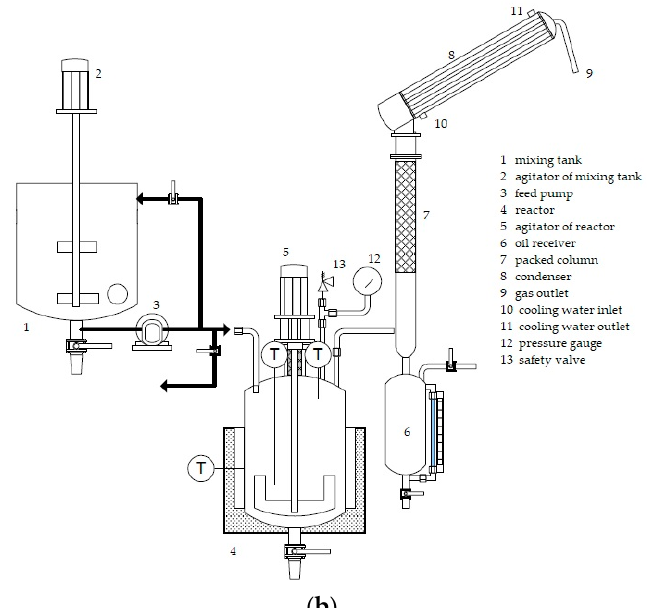
Figure 2. Co-pyrolysis prototype for a 10 kg/day process: ( a ) photograph of the prototype setup; ( b ) diagram of the prototype. Table 1. Specification of process conditions at lab-scale and prototype-scale.